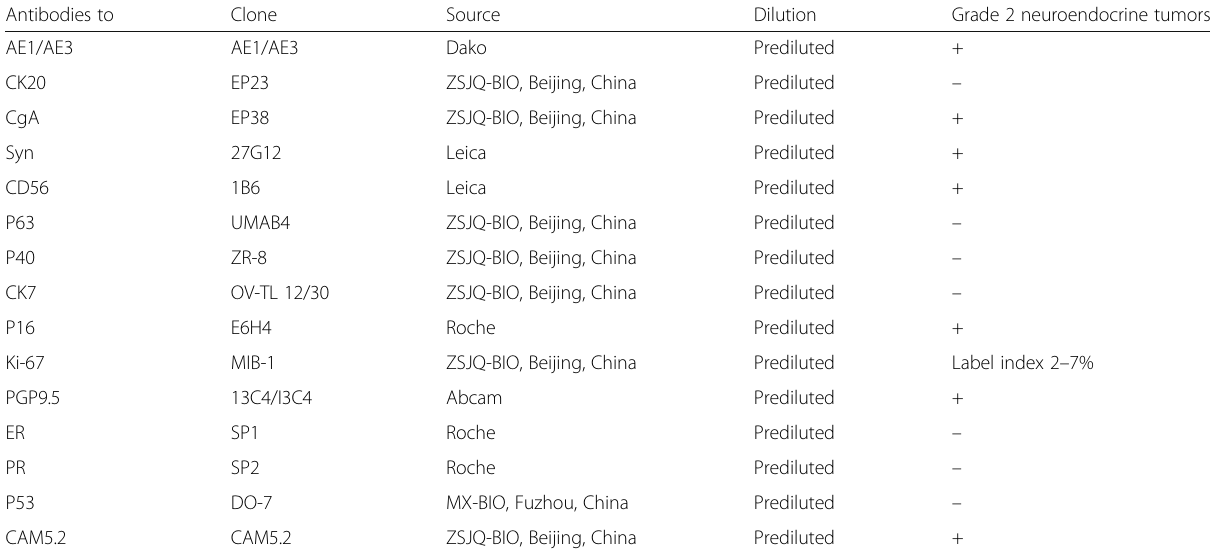
Table 1 Clones, Dilutions, Sources and Results of Antibodies Used in the Immunohistochemical Panel Antibodies to Clone Source Dilution Grade 2 neuroendocrine tumors AE1/AE3 AE1/AE3 Dako Prediluted + CK20 EP23 ZSJQ-BIO, Beijing, China Prediluted – EP38